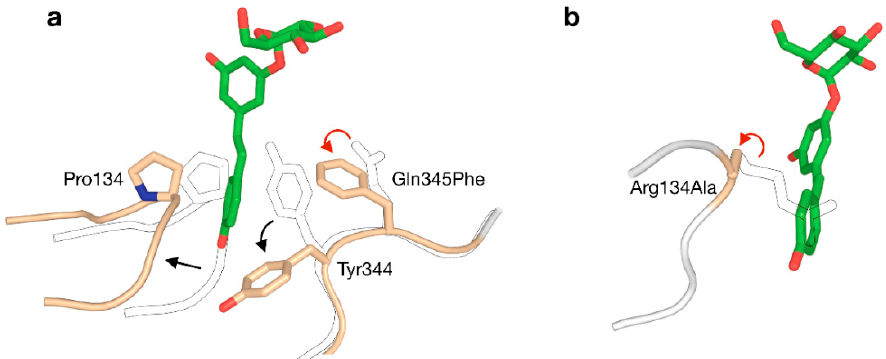
Figure 5. Two strategies for enlarging the acceptor site of GH13_18 phosphorylases to enable glycosylation of resveratrol (red arrow: mutation; black arrow: conformational shift). ( a ) The Q345F mutation in BaSP triggers a clash-induced cascade of conformational changes. ( b ) The R134A mutation in TtSPP broadens the entrance to the active site. The outlined loops and sidechains represent the wild-type.